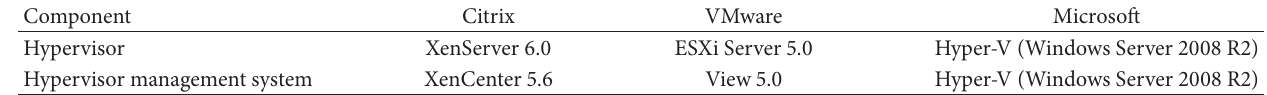
Table 1: Hypervisor and desktop virtualization solutions.